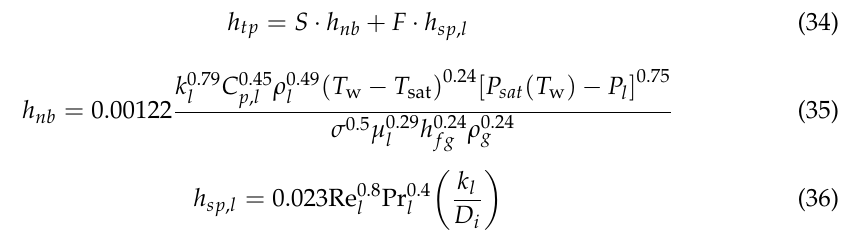
Figure 5. Local void fraction and liquid phase velocity distribution near the position.